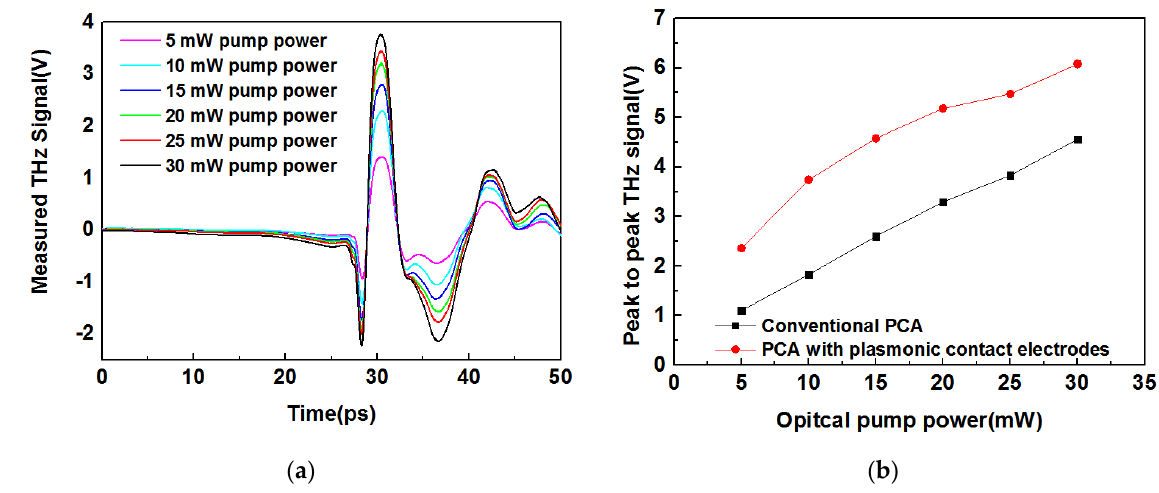
Figure 8. ( a ) The measured THz signals and ( b ) extracted peak-to-peak THz signals of the proposed PCA as a function of the optical pump power.